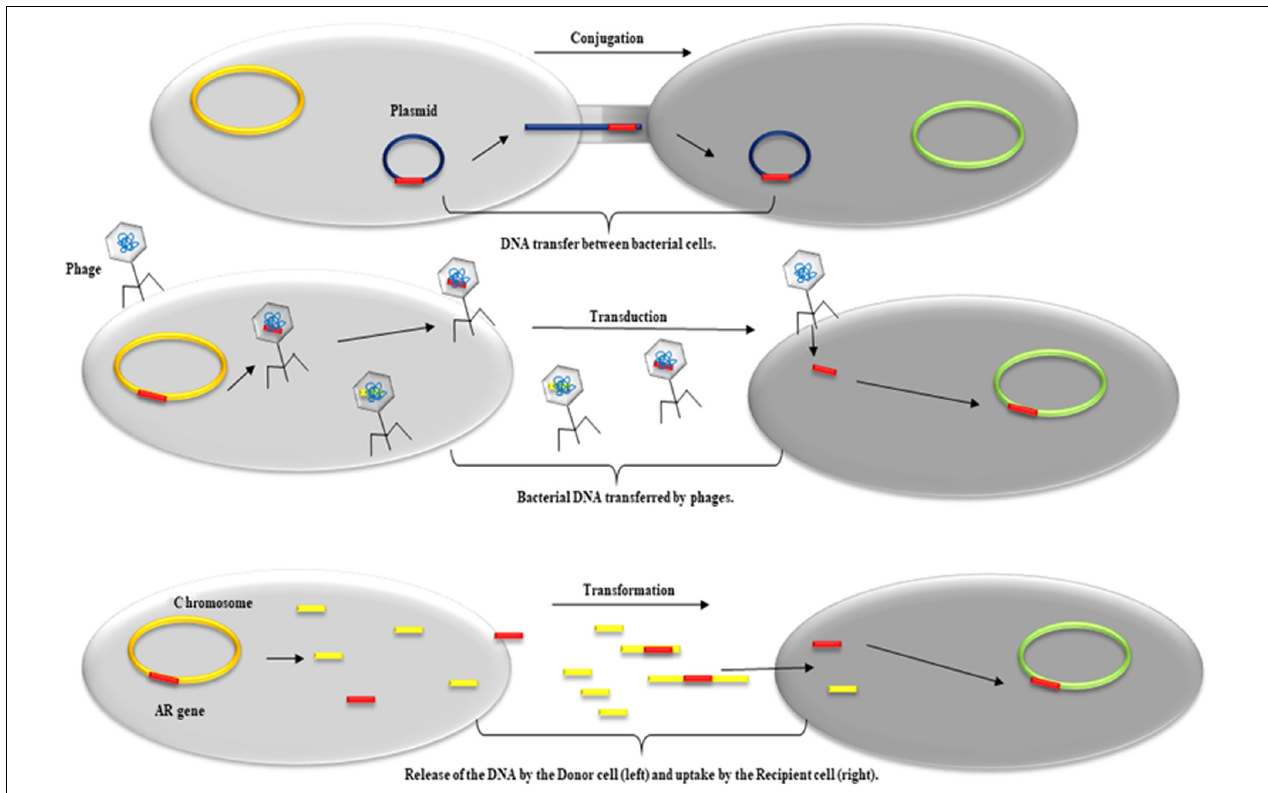
FIGURE 1 | Schematic representation of the predominant HTG mechanisms involved in the acquisition and dissemination of genetic material such as ARG. From top to bottom: Conjugation , DNA transfer between a donor cell (left) and a recipient cell (right) mediated by plasmids; Transduction , transfer of bacterial DNA between a donor cell (left) and a recipient cell (right) mediated by phages; Transformation , release of DNA by a donor cell (left) and uptake by a recipient cell